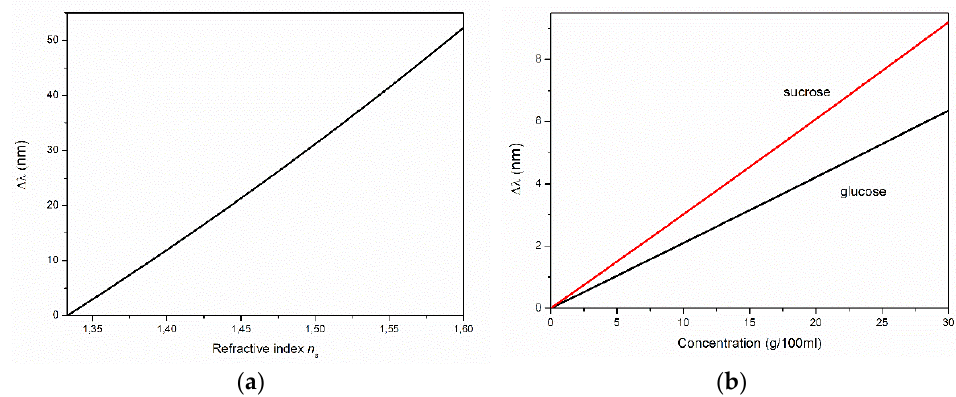
Figure 7. Estimation of the shift in the interference fringe with a maximum at 739 nm at α = 45° with an increase in ( a ) the refractive index of the substance in contact with the ZnO film; ( b ) the concentrations of glucose (black) and sucrose (red) in the aqueous solutions.